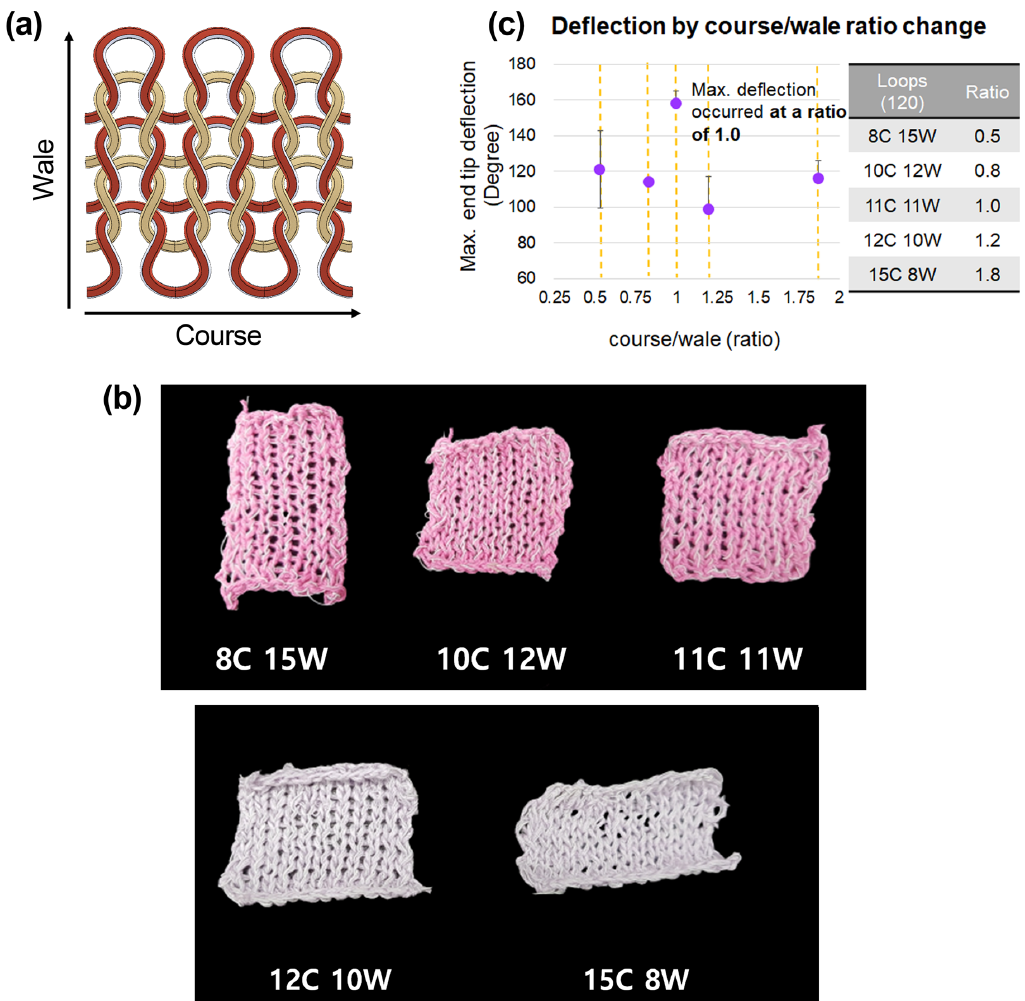
Figure 4. ( a ) Schematic diagram of knitted fabric. ( b ) The appearance of the actuator by course-to- wale ratio. ( c ) The deformations of actuators with different composition ratios of courses and wales.